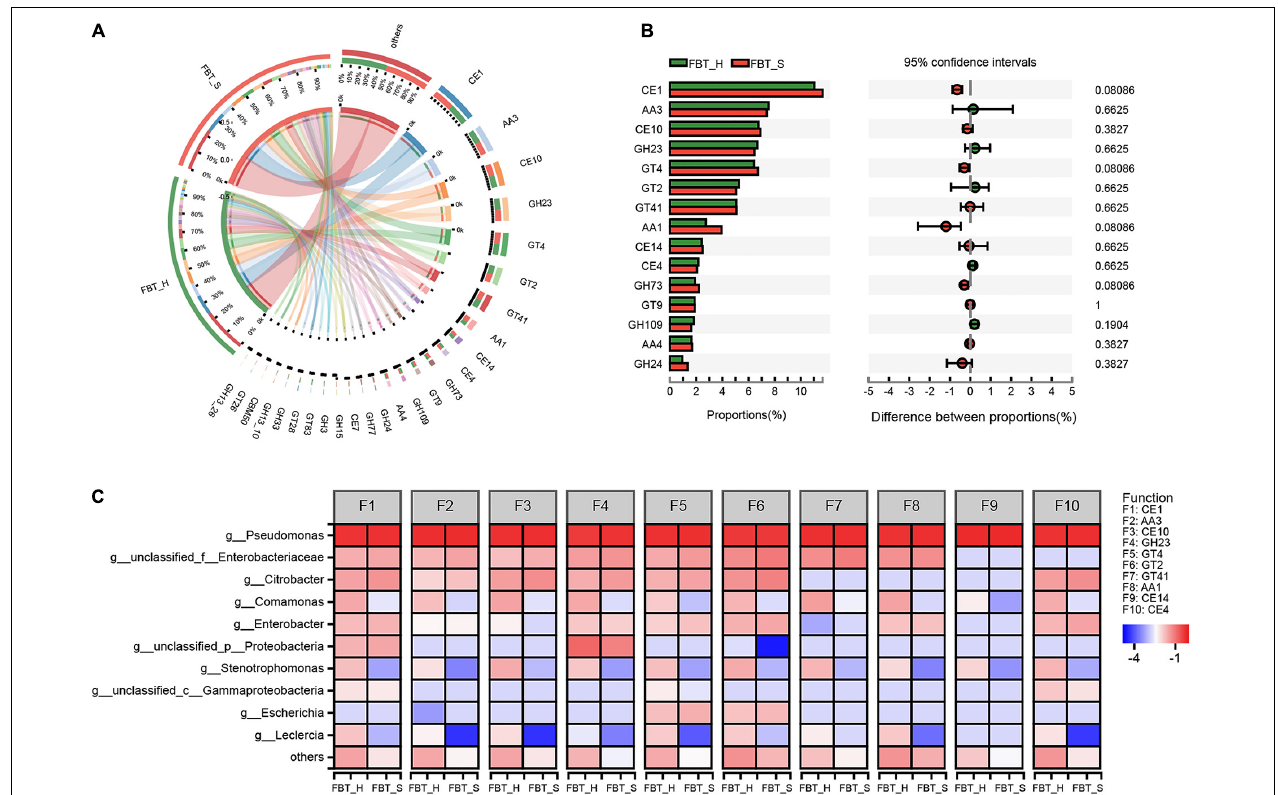
FIGURE 5 | Distribution of CAZyme database functions. (A) The overall distribution of CAZyme among FBT samples. The length of bars for each FBT on the outer ring represents the percentage of CAZymes within each FBT sample. (B) Comparison of CAZyme functions between FBT_H and FBT_S samples. The data were visualized using STAMP (error bars represent Wilcoxon rank-sum test). (C) The contribution of species to CAZyme functional profiles. AA, auxiliary activities; CBM, carbohydrate-binding modules; CE, carbohydrate esterases; GH, glycoside hydrolases; GT, glycosyl transferases; PL, polysaccharide